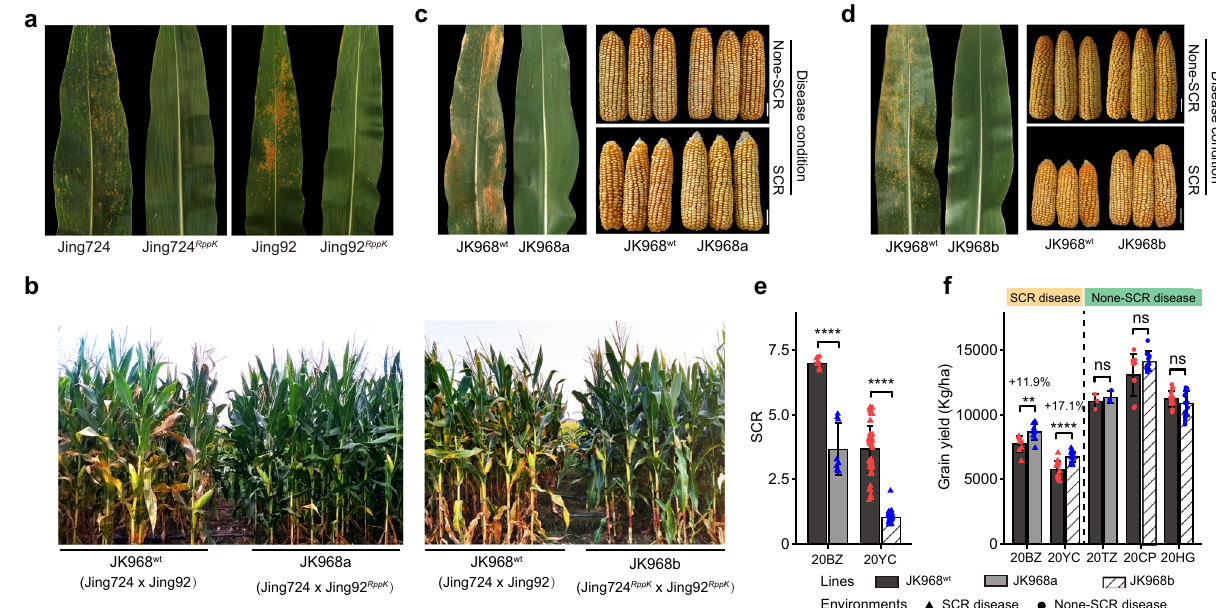
Fig. 2 | RppK improves the grain yield ofmaize hybrid JK968 (Jing724×Jing92) in the presence of SCR disease. a SCR disease phenotypes of wild-type lines (Jing724 and Jing92) and improved lines (Jing724 RppK and Jing92 RppK ) carrying the RppK allele under fi eld conditions. b The fi eld performance of hybrid JK968 wt , improved hybrid JK968a (Jing724×Jing92 RppK ) and improved hybrid JK968b (Jing724 RppK ×Jing92 RppK ) in the fi eld in the presence of SCR disease. Hybrid JK968a was derived from a cross between Jing724 and Jing92 RppK and Hybrid JK968b was derived from a cross between Jing724 RppK and Jing92 RppK . c SCR disease phenotypes of hybrid JK968 wt and hybrid JK968a under fi eld conditions and ear phenotypes of hybridJK968 wt andhybridsJK968ainthepresenceorabsenceofSCRdisease.Scale bars=3cm. d SCR disease phenotypes of hybrid JK968 wt and hybrid JK968b under fi eld conditions and ear phenotypes of hybrid JK968 wt and hybrids JK968b in the presence or absence of SCR disease. Scale bars=3cm. e The SCR disease